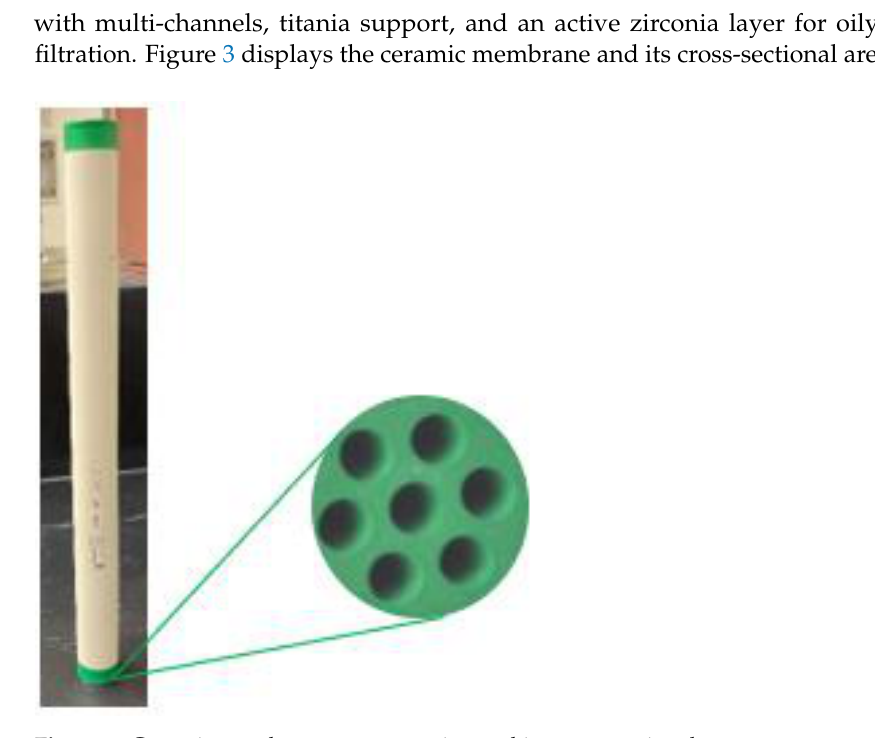
Table 1. Ultrafiltration ceramic membrane